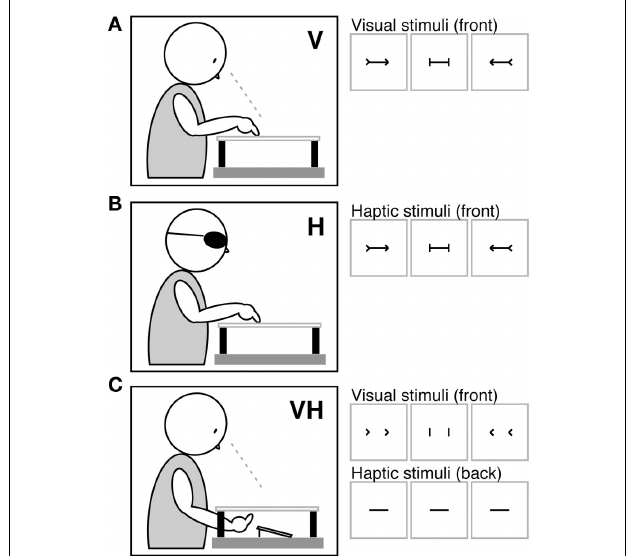
FIGURE 2 | Stimuli and apparatus. Under visual [V (A) ], haptic [H (B) ], and cross modal visuo-haptic [VH (C) ] presentations, three types of stimuli were administered: leftward outgoing/rightward ingoing fins, which brought about a leftward displacement of the shaft’s perceived center; a baseline control stimulus with vertical ends; leftward ingoing/rightward outgoing fins, which brought about a rightward displacement of the shaft’s perceived center. In the visuo-haptic condition (C) the ends were glued on the front of the board, and the horizontal shaft to be bisected on the back, in the correspondent